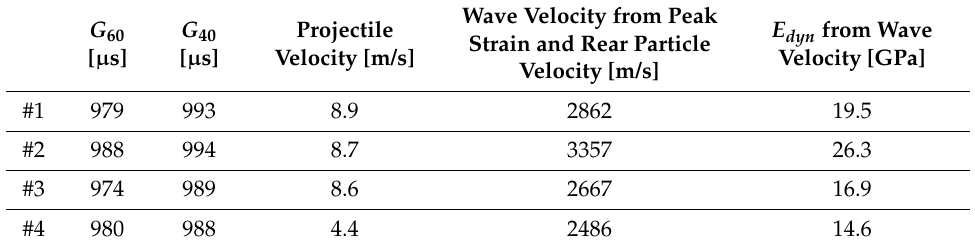
Table 2. Experimental data of the spalling